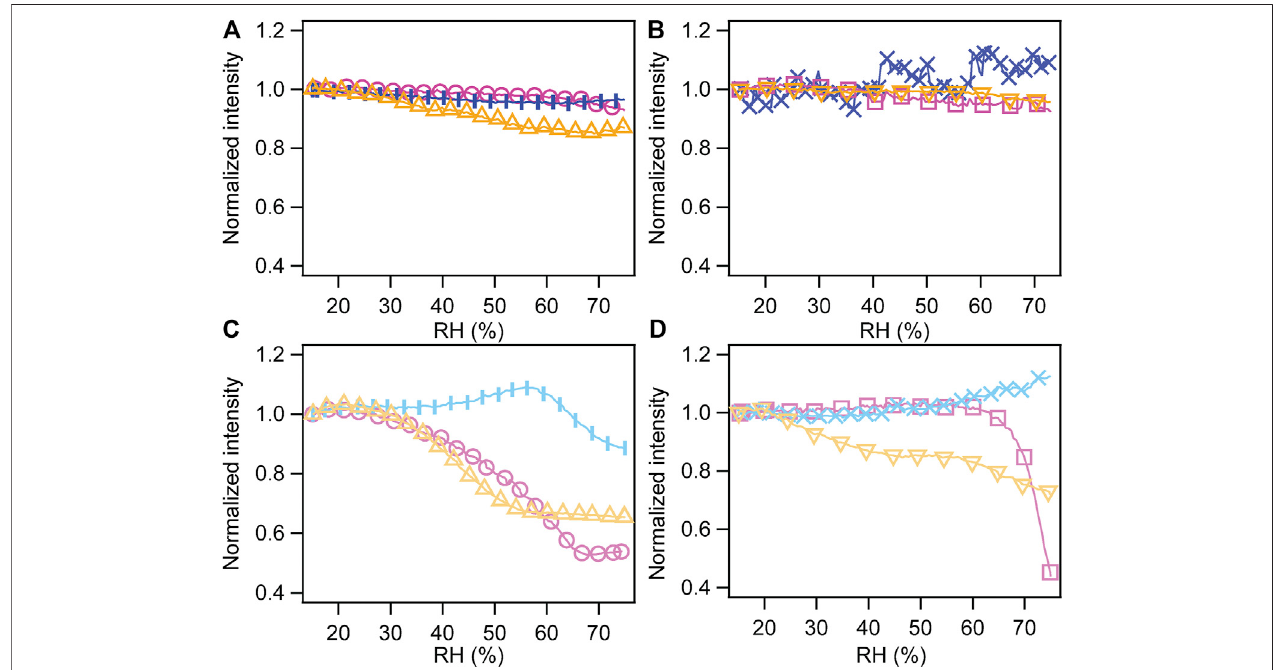
FIGURE 3 | Normalized intensity of peak (110) of the cubic phase (Brij 58) and of peak (200) of the hexagonal phase (P123) as a function of RH. (A) Mesoporous silica prepared with surfactant Brij 58. (B) Mesoporous silica with the P123 templating agent. (C) Mesoporous silica with Brij 58 functionalized with APTES. (D) MesoporoussilicawithP123functionalizedwithAPTES.Pinkcurvesrepresent thermallytreatedsamples(circles,Brij58;squares,P123),blueonesrepresentirradiated and developed ones (verticalbar markers, Brij 58; xmarkers, P123), and yellow ones represent irradiated, developed, and thermallytreated ones (triangles with tip up, Brij 58; triangles with tip down,